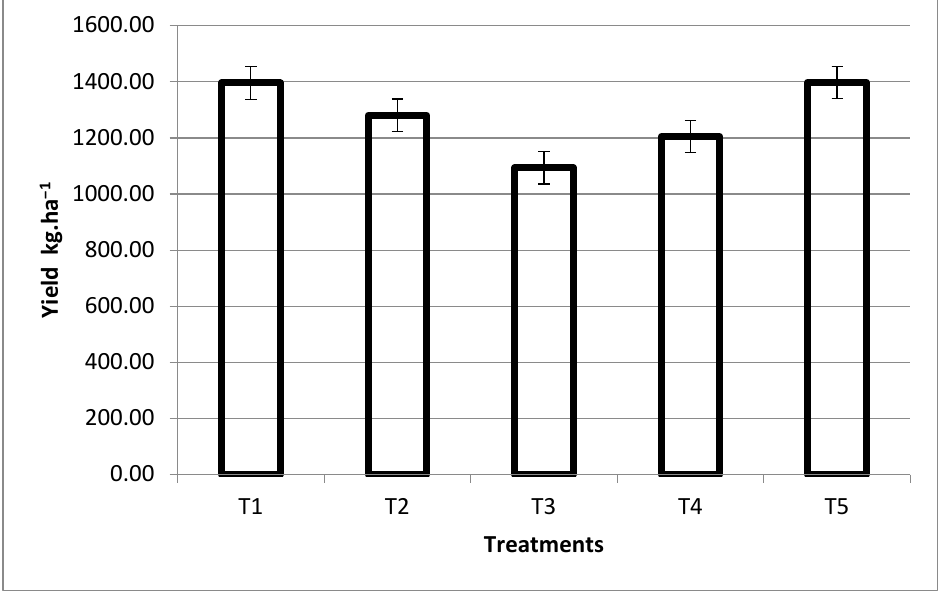
Figure 1. Effect of fertilization treatments on maize grain yield. T 1 = basal application of the digestate from swine wastewater as total substitute (100%) for synthetic N; T 2 = foliar application of the digestate as total substitute (100%) for synthetic N; T 3 = basal application of the digestate as partial substitute (50%) for synthetic N; T 4 = foliar application of the digestate as partial substitute (50%) for synthetic N; T 5 = in-row broadcast of mineral fertilizers. The treatments are fully described in Table 3. Mean bars with no letter or same letters are not statistically different (Tukey’s HSD, p < 0.05, n = 4). Error bars indicate standard deviations.